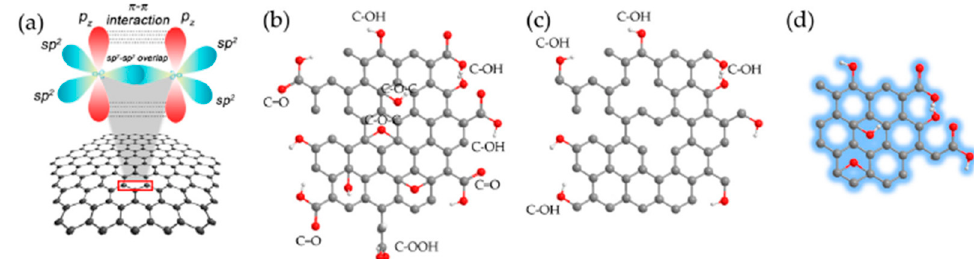
Figure 1. Structures of graphene-based nanomaterials, including pristine graphene (pure-arranged carbon atoms) with sp 2 -hybridized carbon atoms ( a ) and the chemically modified graphene: graphene oxide (GO) ( b ), reduced graphene oxide (rGO) ( c ), and graphene quantum dot (GQD) ( d ). Reprinted and adapted with permission from [4]. Copyright MDPI, 2017.